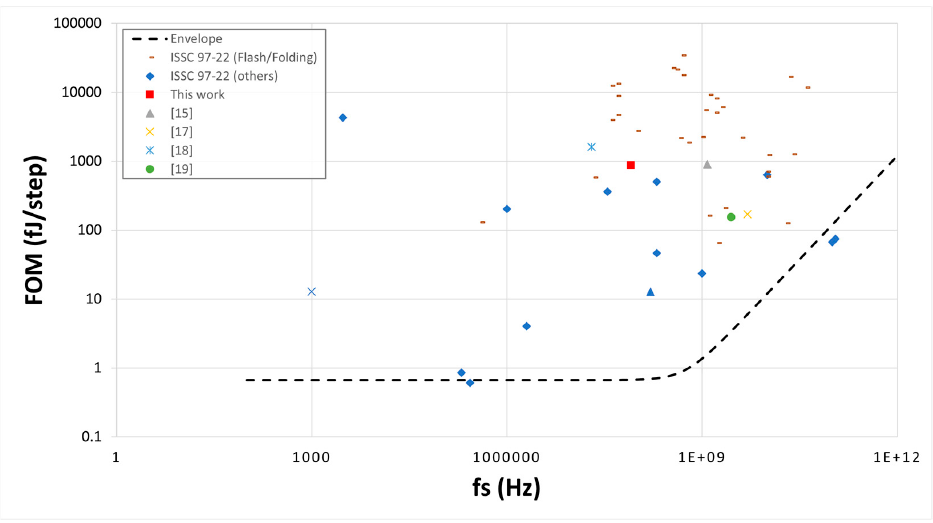
Figure 21. FOM vs. sampling rate.